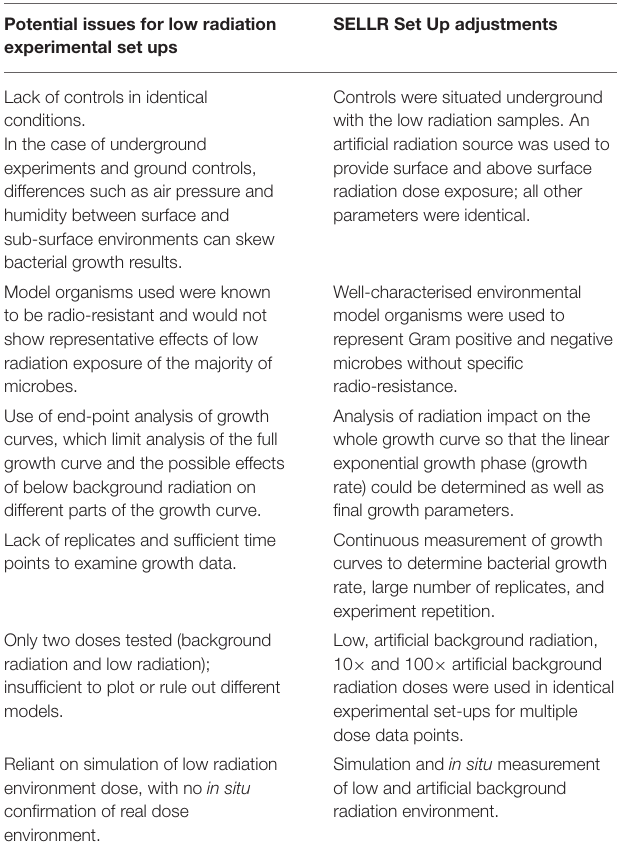
SELLR Set Up adjustments